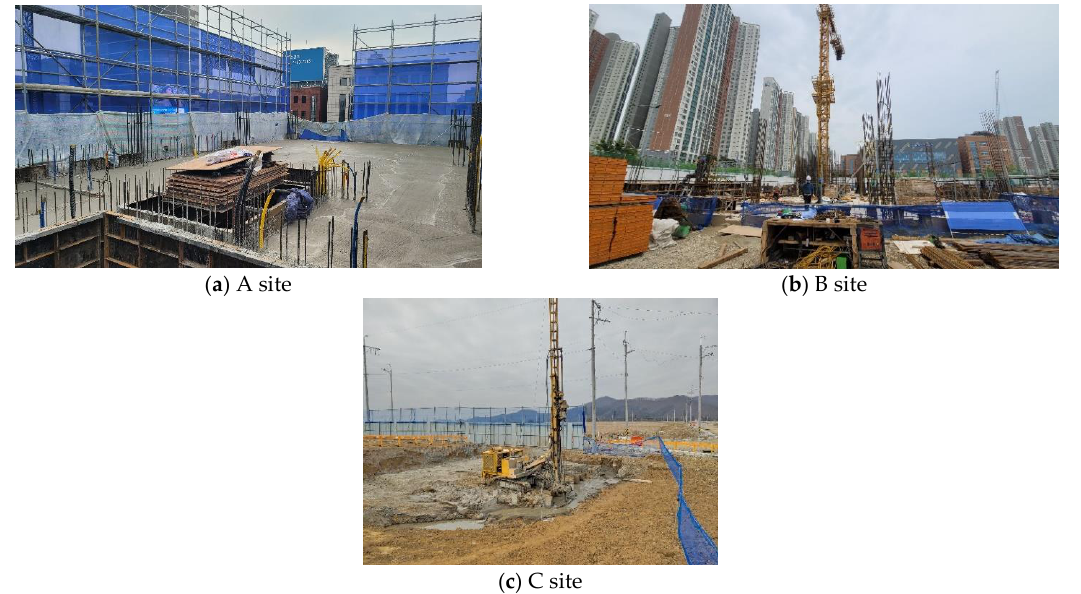
Figure 5. Site images of the selected test beds.